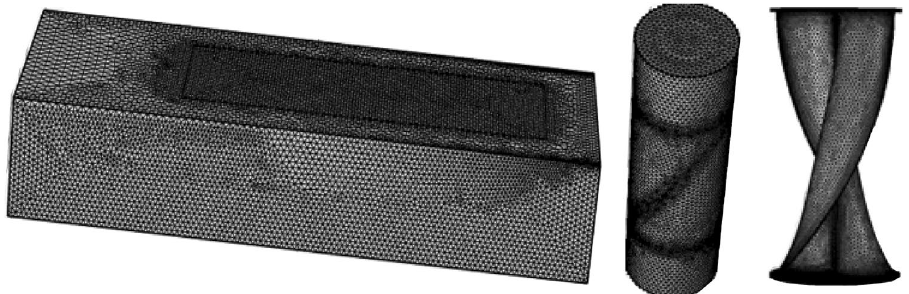
Fig. 5 The schematic of domain discretization (mesh- ing)